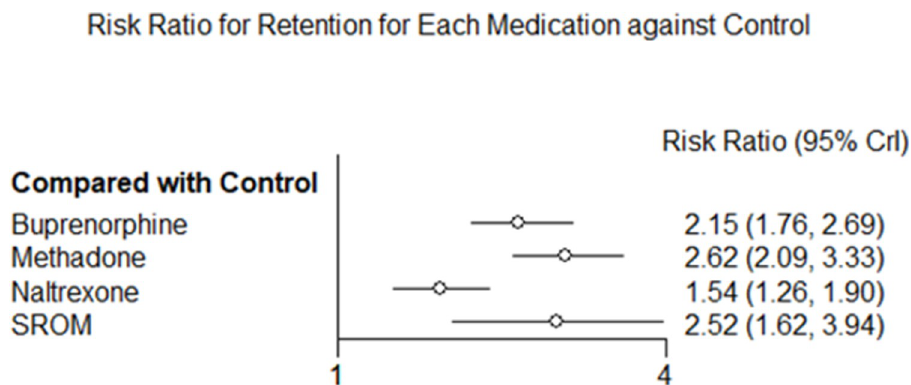
Fig 3. Forest plot of the risk ratio for treatment retention for each pharmacotherapy compared to the control group.